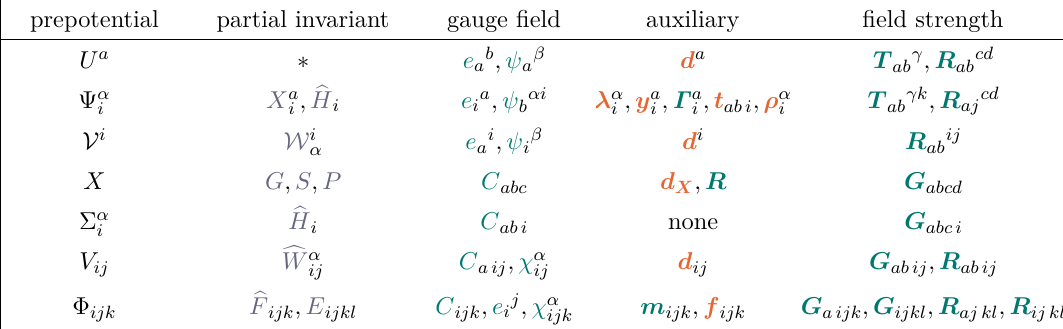
Table 4 . Prepotentials and their derived quantities. All derived quantities contain admixtures of other prepotentials, so these identifications are approximate. (The assignment of curvature tensor components to any one field is similarly ambiguous.) Explicit formulæ for partial invariants in terms of the prepotentials are deferred to appendix C. (Hatted quantities are Ψ -corrected versions of the naïve hierarchy field strengths.) The dimension- 1 , 3 , 2 components of the field strength G , 2 torsion T , and curvature R are the curls of the gauge fields as described in section